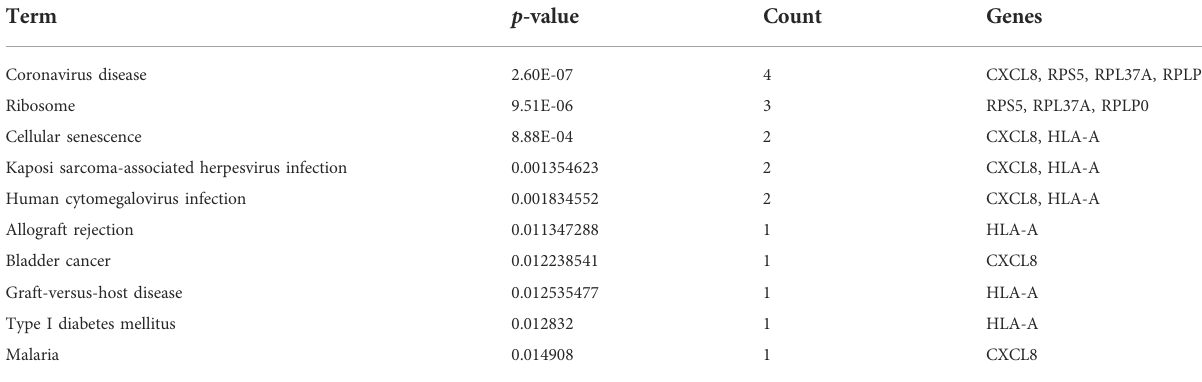
TABLE 4 The pathway analysis of hub genes in